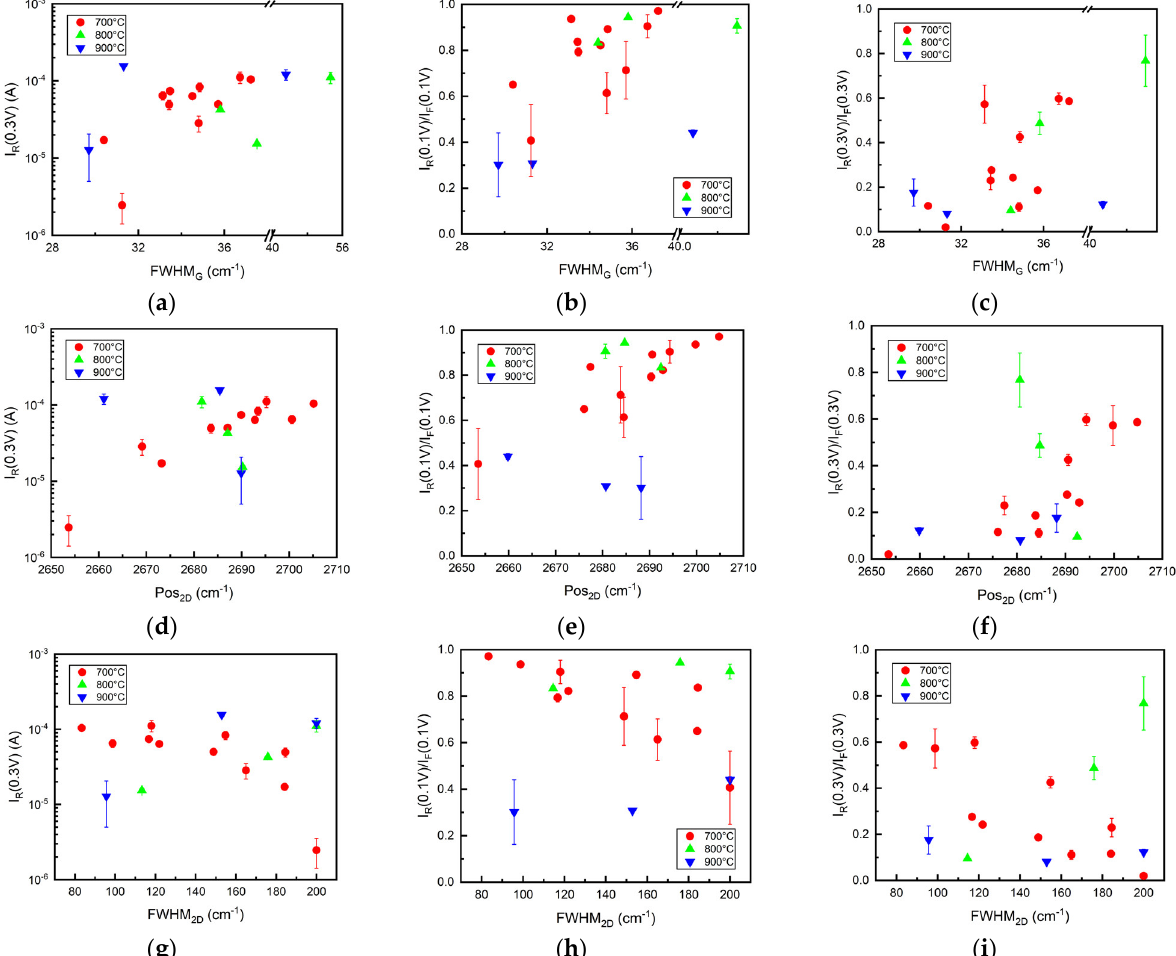
Figure 4. I−V characteristic parameters (I R (0.3 V), I R (0.1 V)/I F (0.1 V), I R (0.3 V)/I F (0.3 V)) in relation with: ( a – c ) FWHM G ; ( d – f ) Pos 2D ; and ( g – i ) FWHM 2D . Samples were grouped according to the temperature of Si(100) substrate hydrogen plasma annealing before graphene growth: 700 °C (red), 800 °C (green), 900 °C (blue).